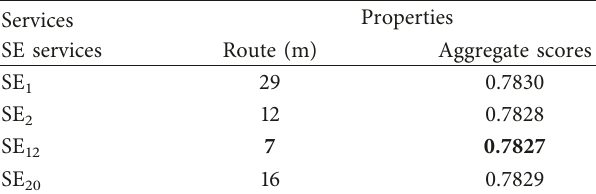
Table 3: Shortest route-based